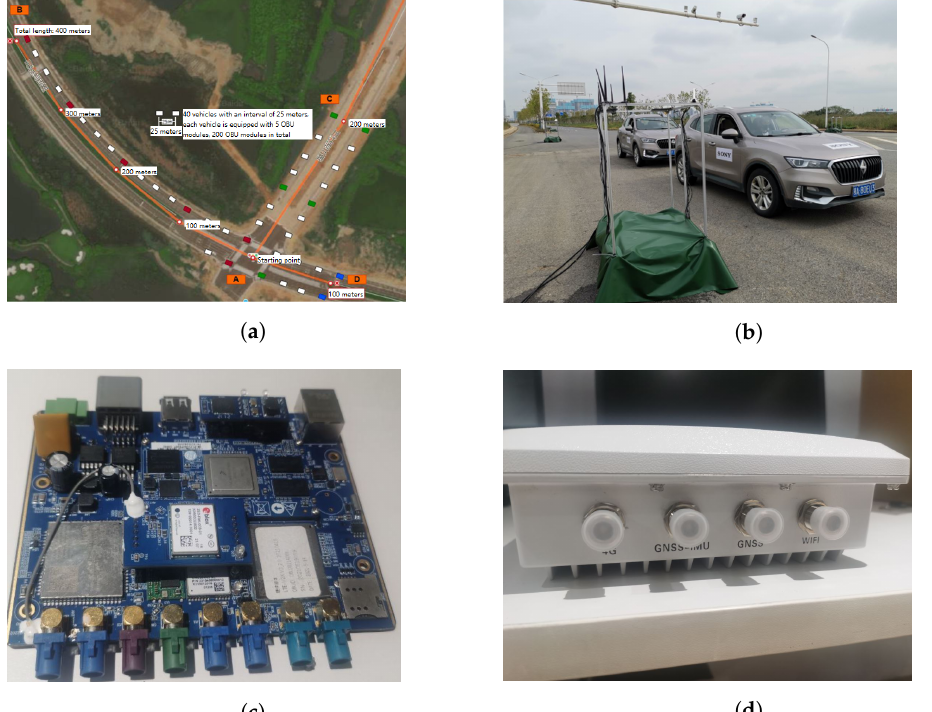
Figure 1. IMT-2020 Wuhan large-scale interoperability test and Sony test devices. ( a ) Test road bird view map. ( b ) Sony test vehicles. ( c ) Sony test OBU. ( d ) Sony test